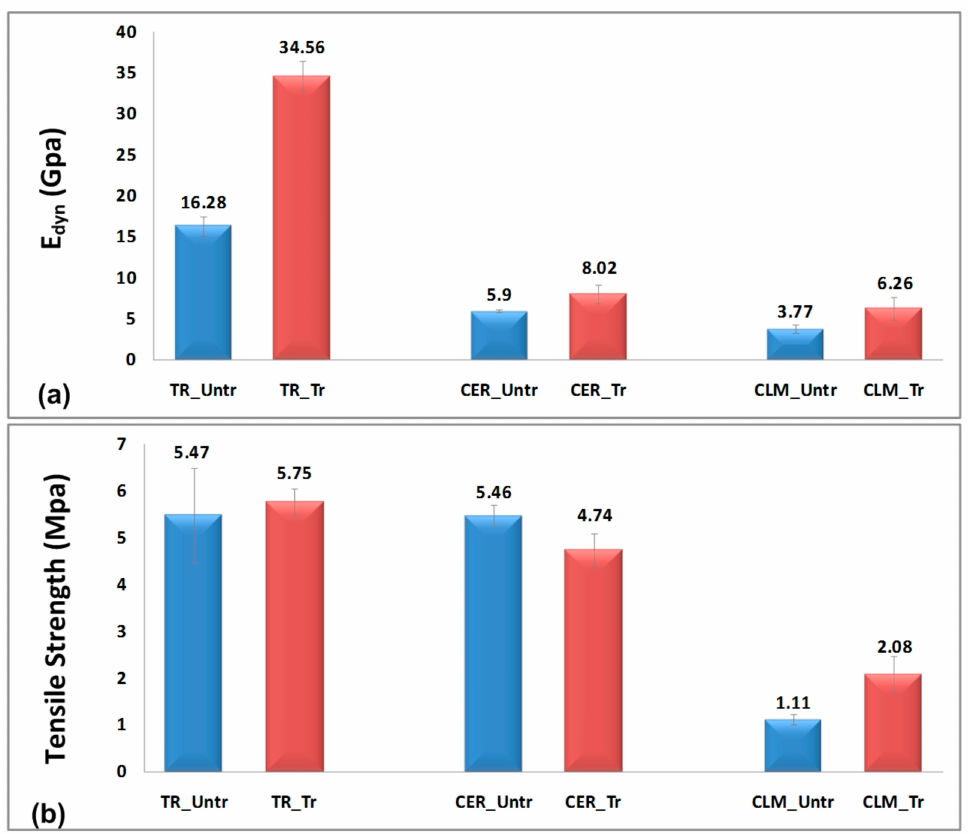
Figure 7. Mechanical Properties: ( a ) Dynamic modulus of elasticity (E dyn ) and ( b ) Tensile Strength of TR, CER and CLM untreated and treated